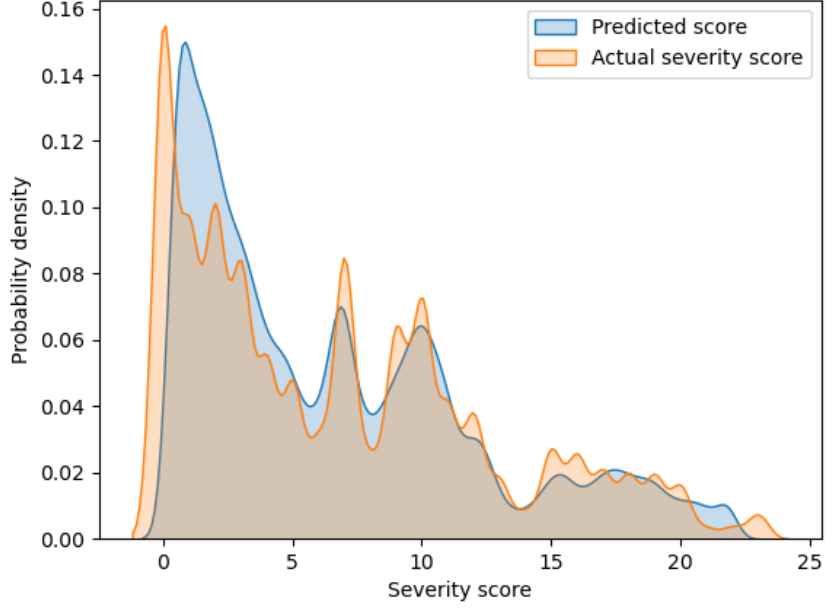
Figure 2. Probability density functions of the predicted scores and actual severity scores.